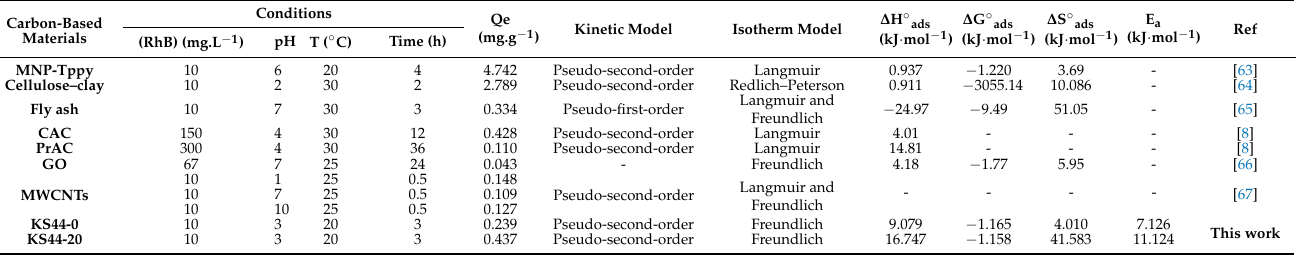
Table 7. Comparison of the Rhodamine B (RhB) dye adsorption capacities and thermodynamic parameters on different carbon